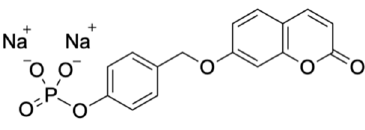
Figure 1. Typical synthetic enzyme substrate structure.